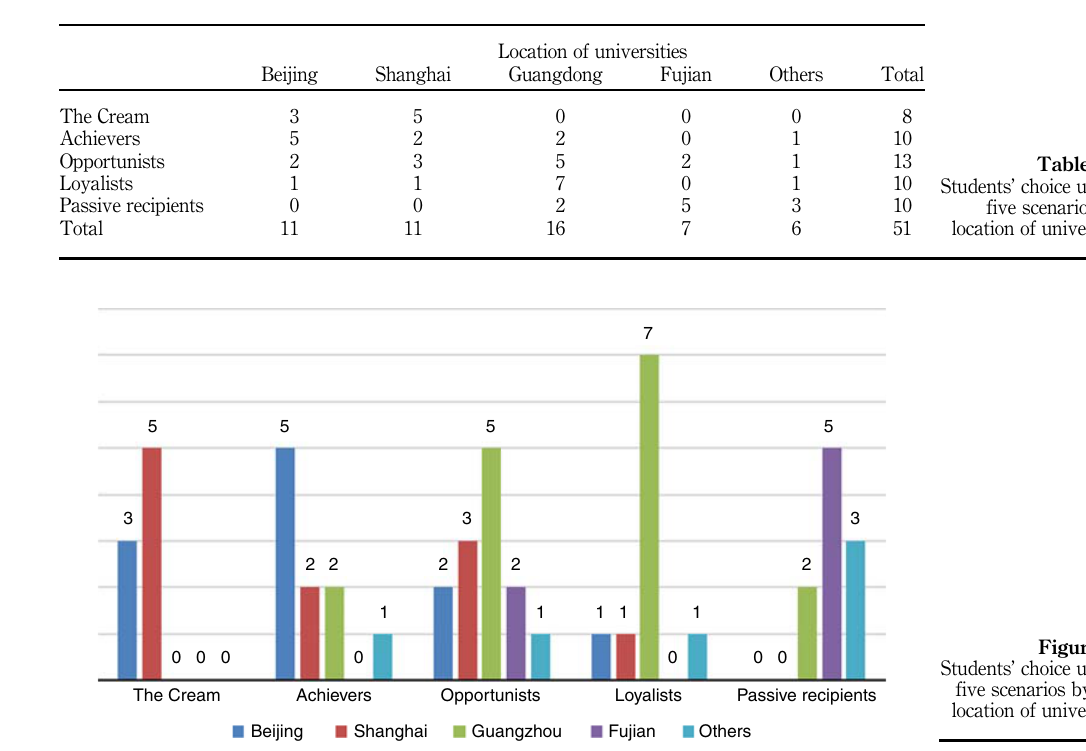
Figure 4. Students ’ choice under five scenarios by the location of